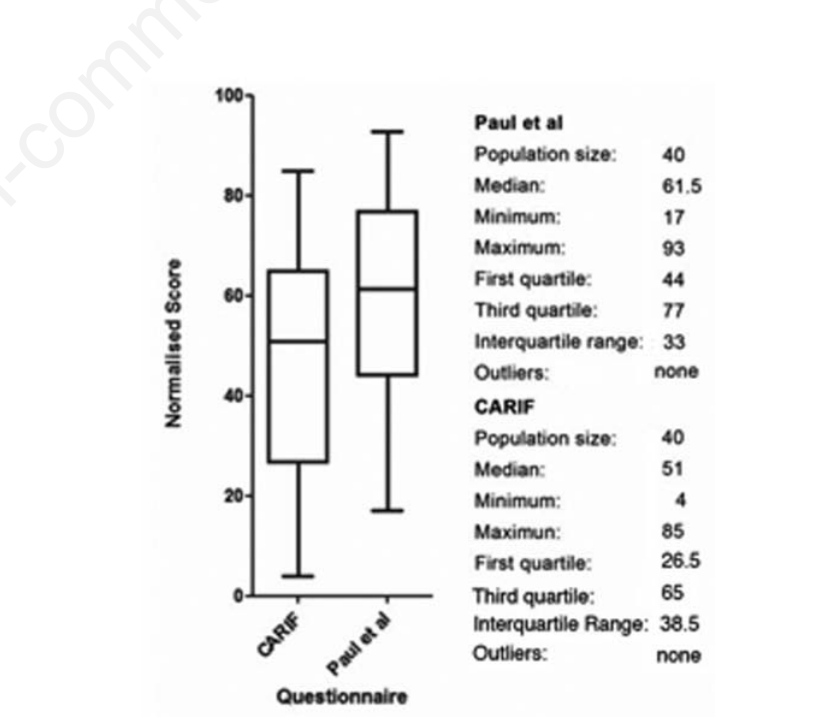
Figure 2. A comparison between the scores obtained on the Canadian Acute Respiratory Illness and Flu Scale and Paul et al. questionnaire. The data has been